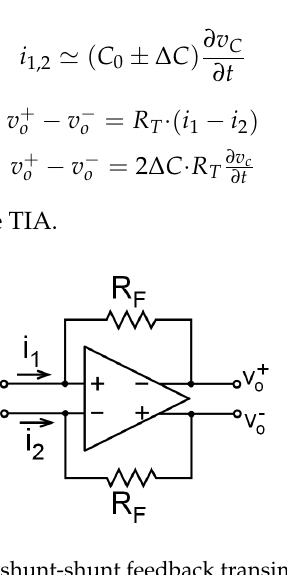
Figure 4. Differential shunt-shunt feedback transimpedance amplifier.